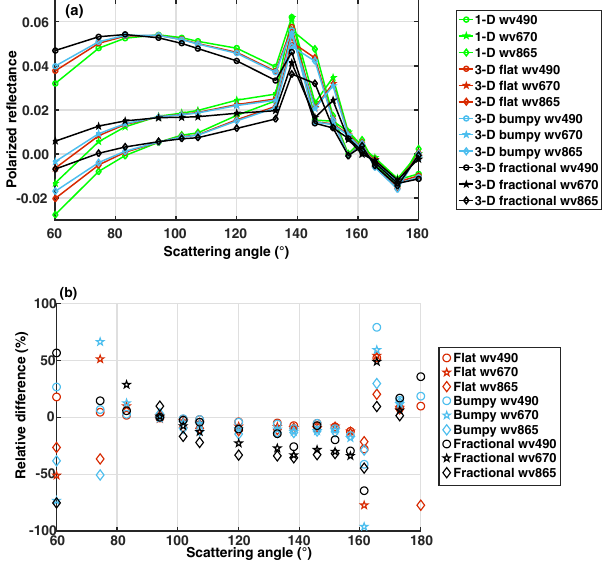
Figure 5. (a) Polarized reflectance as a function of the scattering angle for three wavelengths (490, 670 and 865nm) for the homoge- neous cloud (1-D), the flat cloud, the bumpy cloud and the fractional cloud. (b) Relative difference between 3-D and 1-D polarized re- flectances, [(Rp3-D − Rp1-D) / Rp1-D × 100]. The solar zenith an- gle is 60 ◦